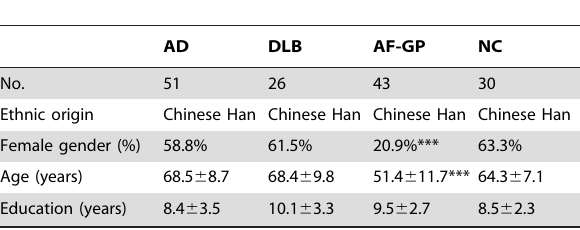
Table 1. Demographic characteristics.